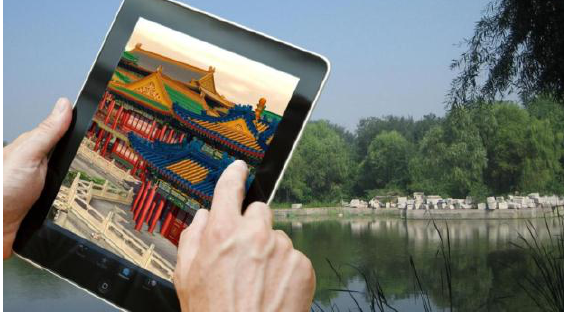
Figure 7. digital exhibition with Ipad